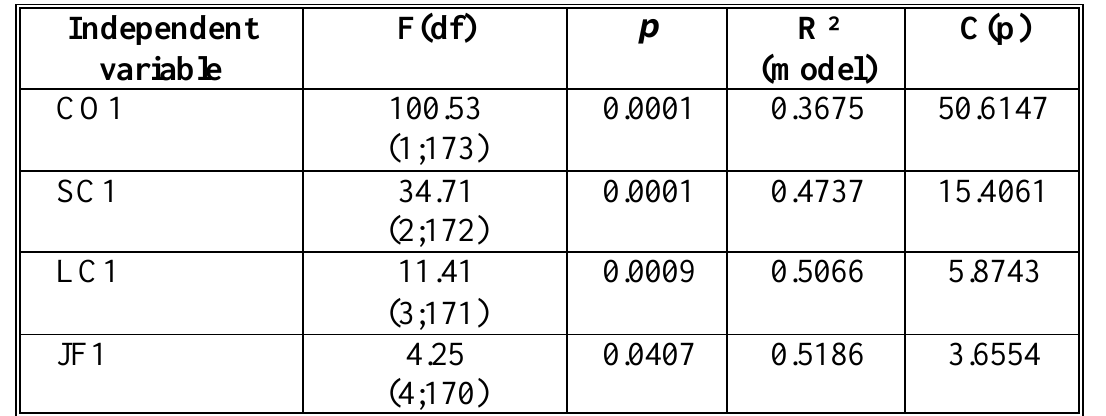
Dependent variable: Entrepreneurial attitude 1: Innovation